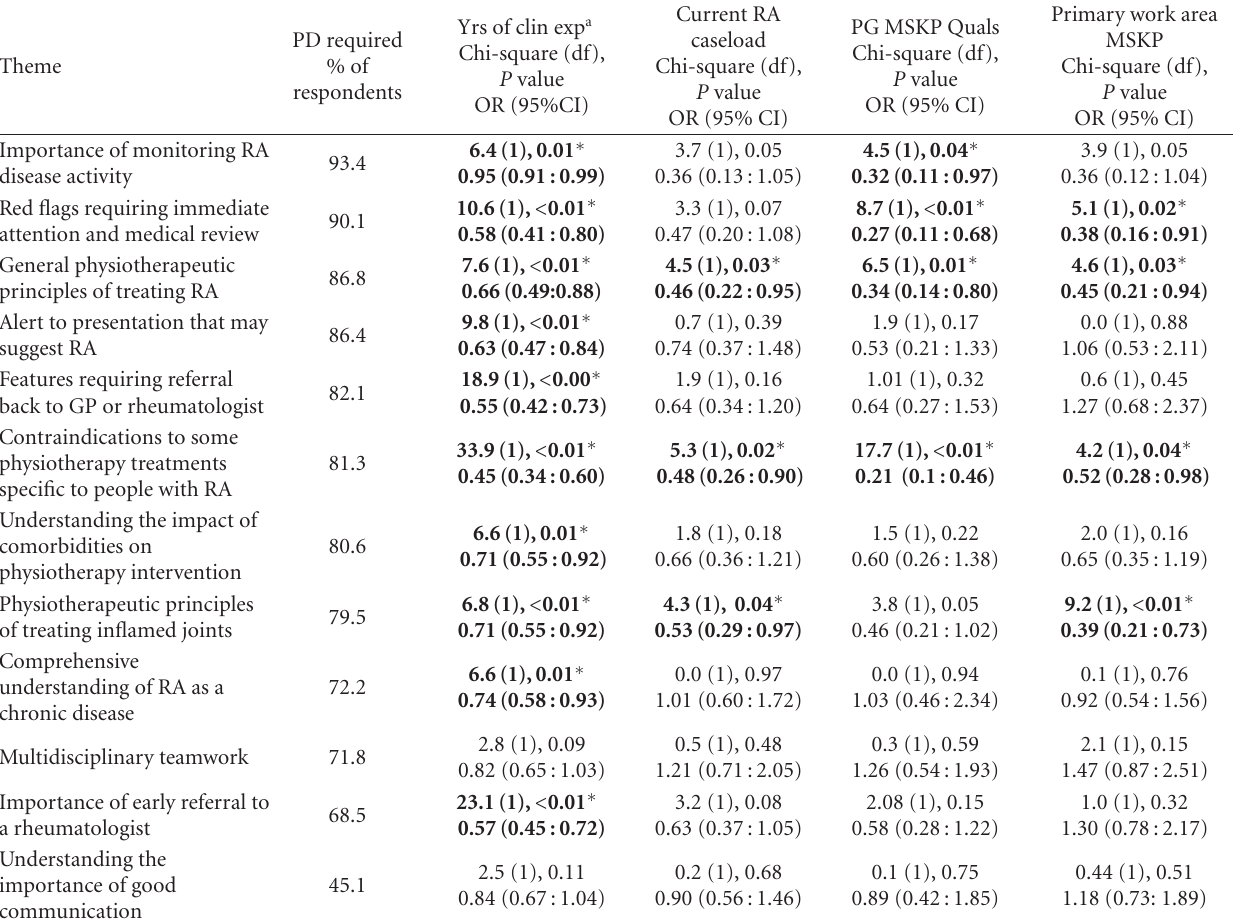
Table 3: Association between PD needs for knowledge items and the variables of years of clinical practice experience, current caseload